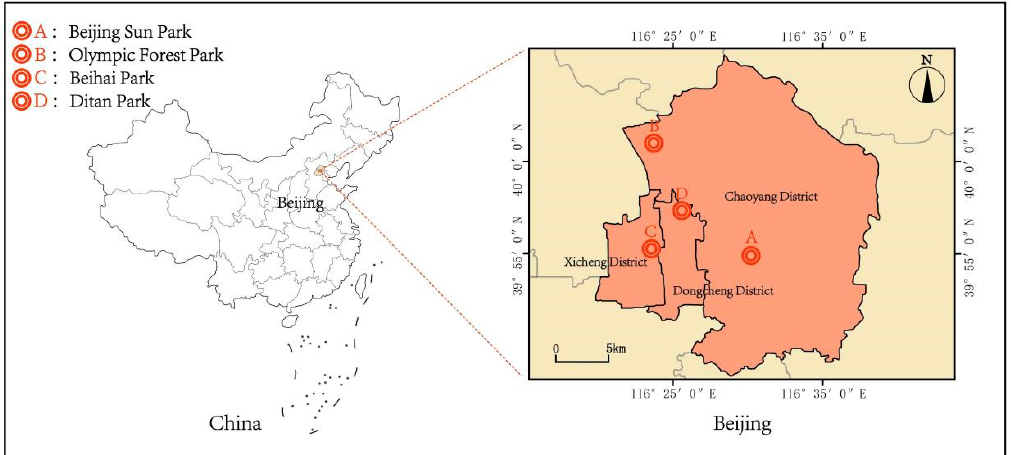
Figure 1. Locations of the study sites. Three districts with the highest population density were selected in the main urban area of Beijing, China, and 1–2 urban parks with high leisure function and eco-logical value were chosen in each district.